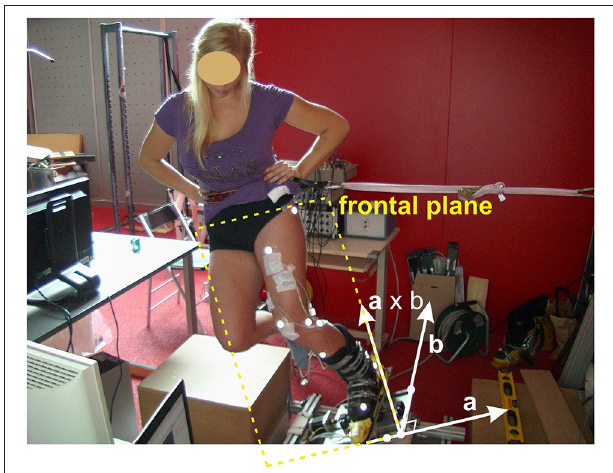
FIGURE 3 | Participant bounded to ski turn simulator. The moving platform, optical markers, and the lateral supporting strap are seen. The frontal plane was calculated using three markers placed on the moving platform that defined two unit vectors. The first vector a was perpendicular, and the second vector b was parallel to the simulator’s axis of rotation. One coordinate of the frontal plane was defined by vector b, and the other by the vector perpendicular to a and b (cross product of vectors a ×